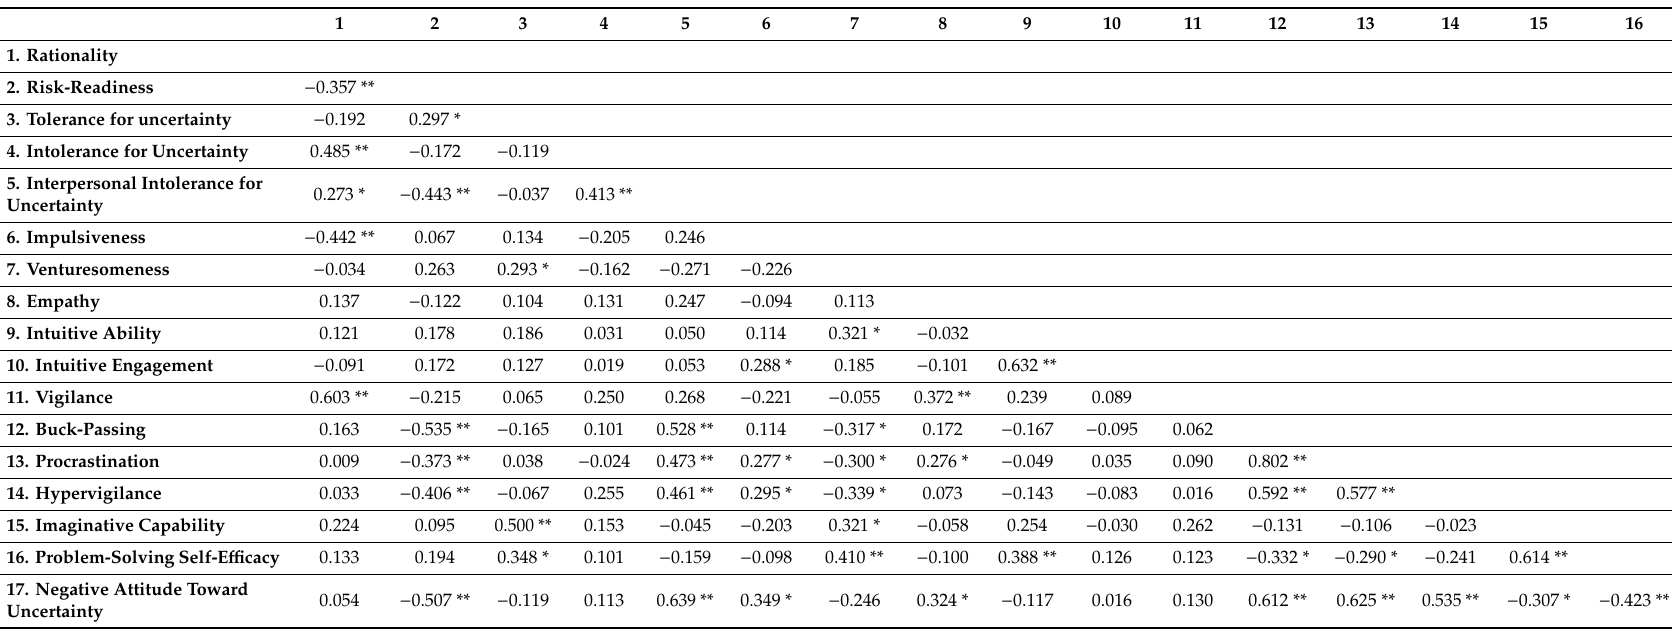
Table A3. Correlations between psychodiagnostics questionnaires